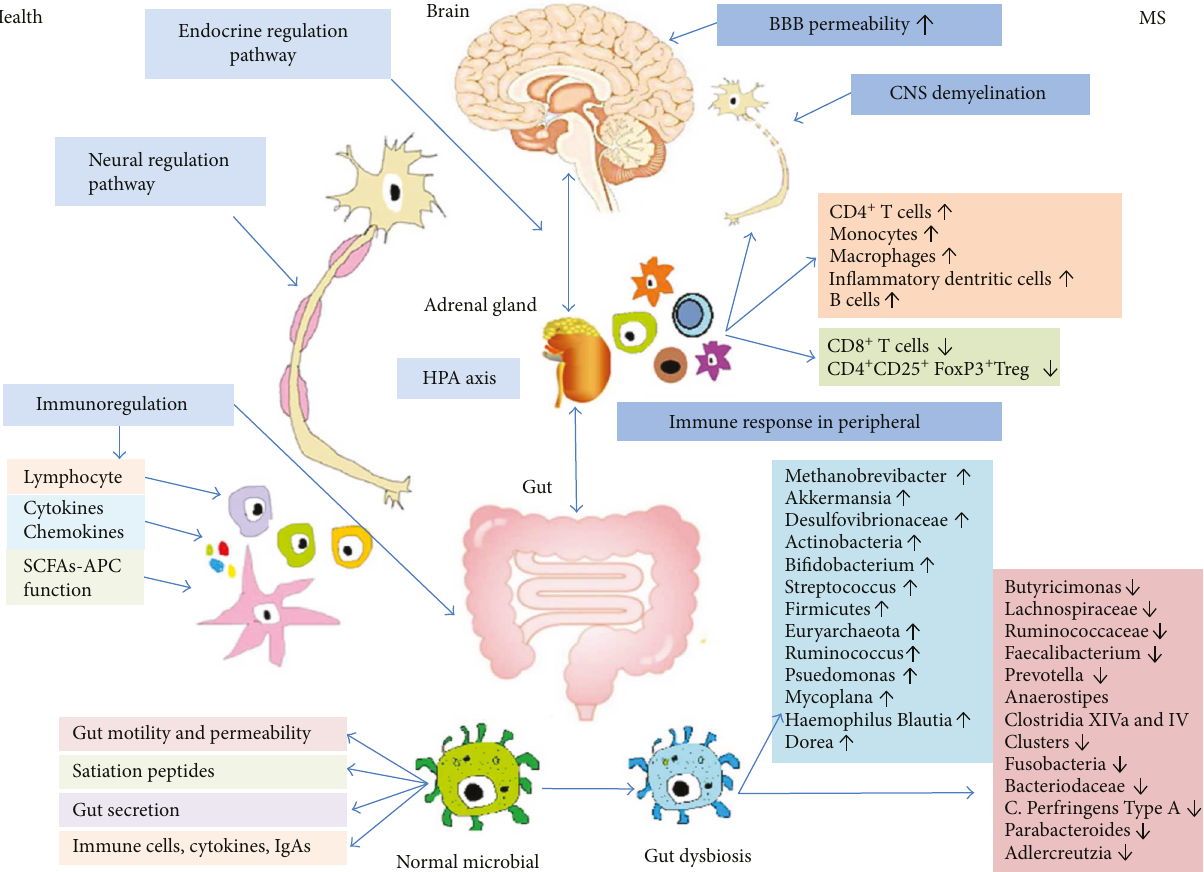
Figure 1: Theroleofthegutmicrobiotain healthand MS.Thegut microbiotacan a ff ectthe body ’ snervous systemfunction innumerousways, including the neural regulating pathway, the endocrine pathway-HPA axis, and the immunoregulating pathway (via lymphocyte, cytokines, chemokines, and antigens presenting e ff ect of SCFAs). The normal microbiome has many functions: (1) maintenance of the motility and permeability of the gut; (2) synthesis and secretion of essential vitamins, such as vitamin B12, folate, vitamin K, nicotinic acid, biotin, ribo fl avin, pyridoxine, panthotenic acid, and thiamine; (3) maintenance of intestinal epithelial functions, such as absorption and secretion; and (4) local stimulation of the development of innate and adaptive immune systems via GALT secreting immune cells, cytokines, and IgAs. When the gut microbiota is in dysbiosis, several diseases may develop, such as MS. The pathology of MS includes increased